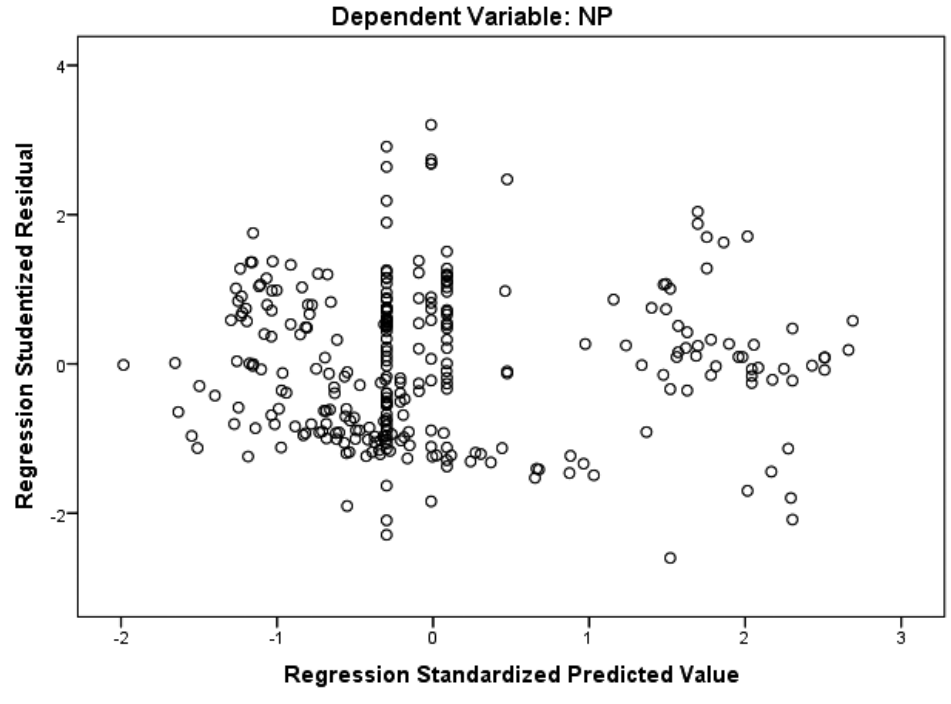
Figure 5. Heteroscedasticity